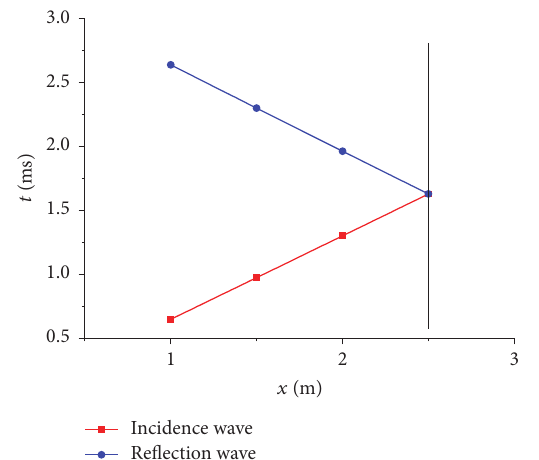
Figure 15: Transfer time (𝑡 - ) distance ( x ) curve of the shock wave for 𝑃 𝑤 = 1MPa and 𝑈 𝑚 = 9 kV.